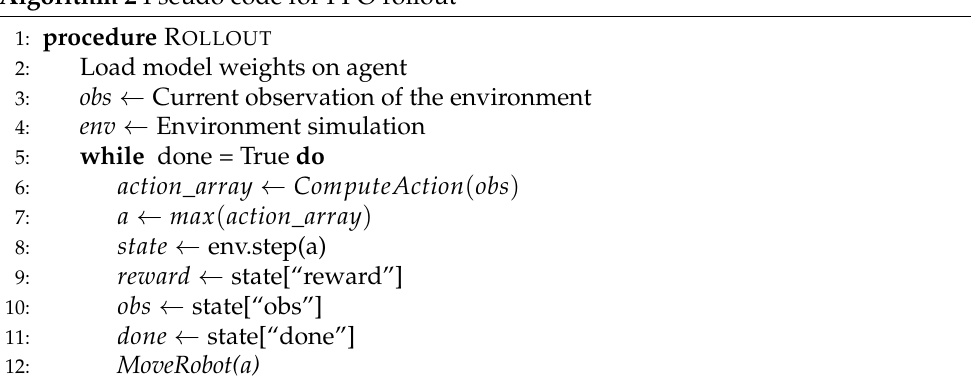
Algorithm 2 Pseudo code for PPO